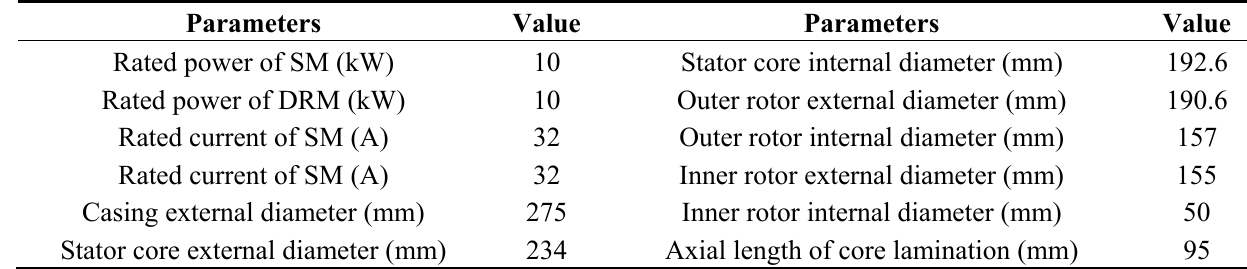
Table 1. Main parameters of the